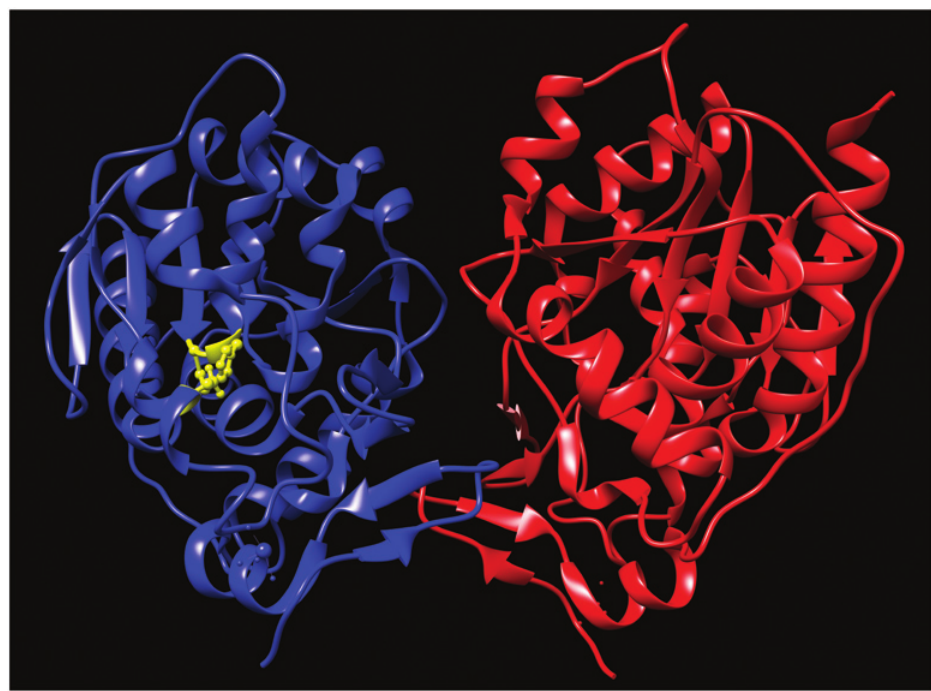
Figure 9: X-ray structure of homodimeric E. coli Hsp31/Glo3 with two subunits colored in red and blue. The active site containing Cys184, His185 and Asp213 as shown in one of the subunits in ball-and stick (yellow) (PDB:1N57).